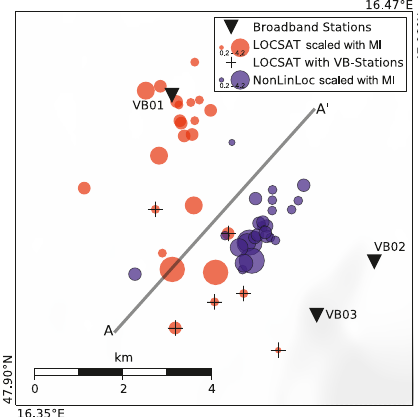
Figure 2. Comparison of epicentral locations calculated with dif- ferent approaches. Profile A parallel to fault direction by Peresson and Decker (1997).